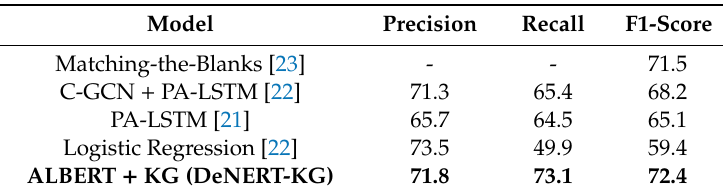
Table 7. Comparison result on TACRED